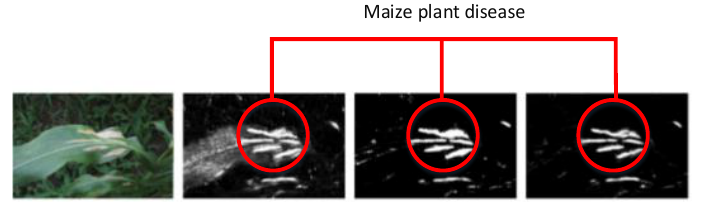
Figure 6. Detection of maize disease (indicated by red circles) by heat map [70] .